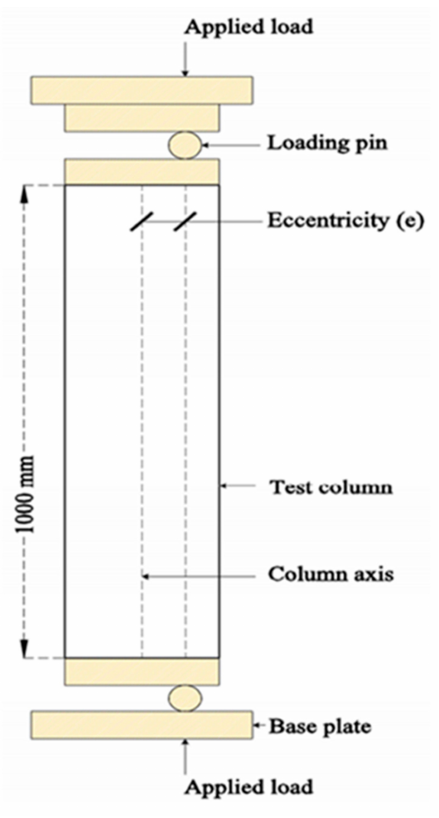
Figure 2. The loading setup for eccentric axial loading of